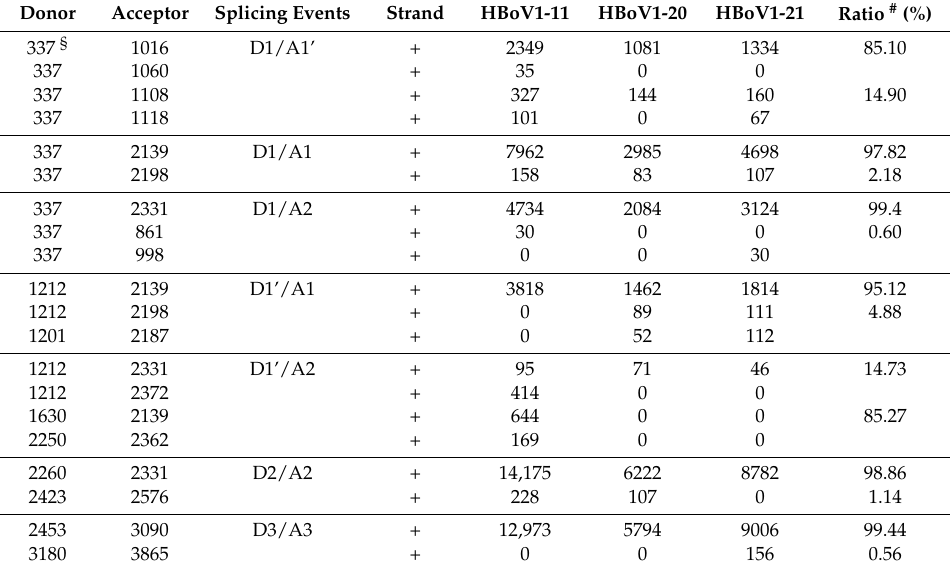
Table 2. Detected splicing events in HBoV1 infected HAE cells.